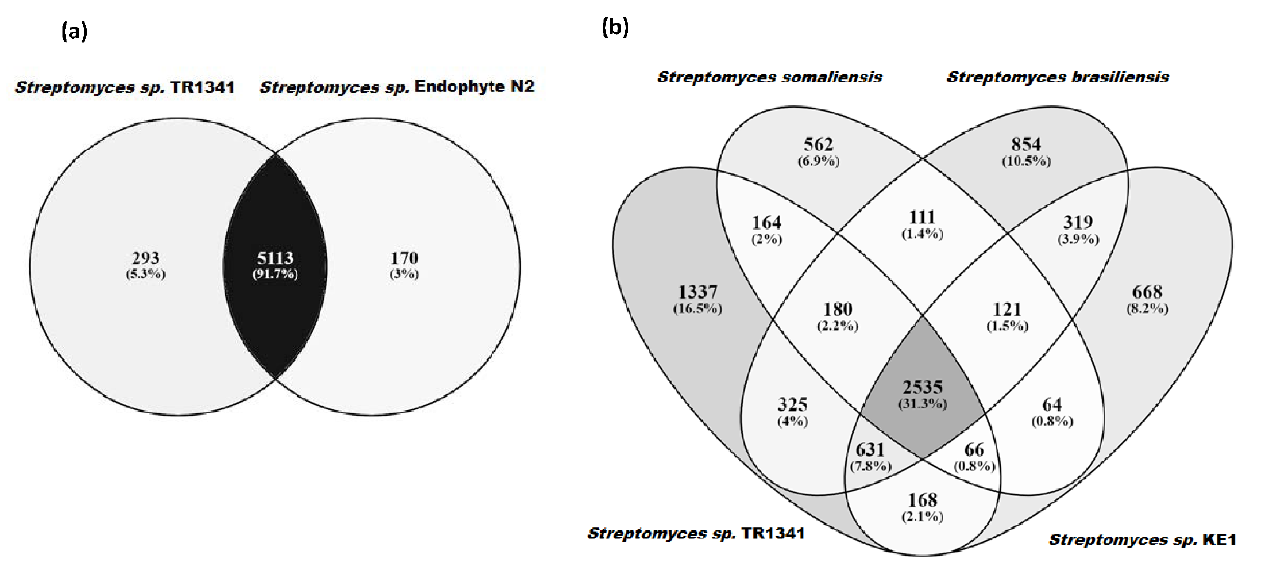
Figure 2. Comparison of orthologous groups in ( a ) Streptomyces sp. TR1341 with the closely related Streptomyces sp. endophyte_N2, and ( b ) the human-associated Streptomyces species: Streptomyces somaliensis DSM 40738, Streptomyces brasiliensis NRRL B-1626, and Streptomyces sp. KE1.